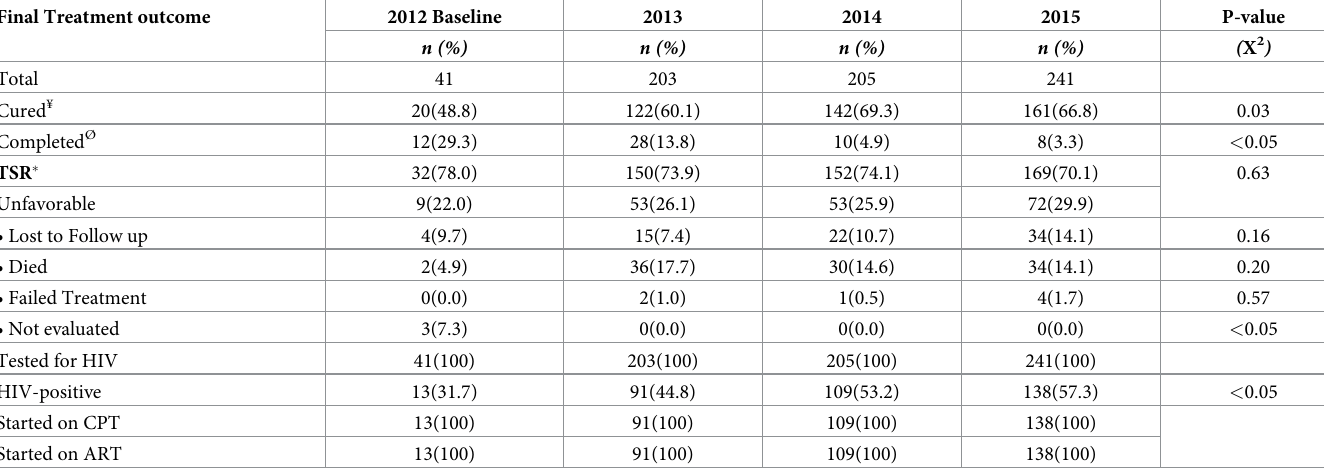
Table 5. Final treatment outcomes for RR-TB/MDR-TB patients enrolled in 2012 and